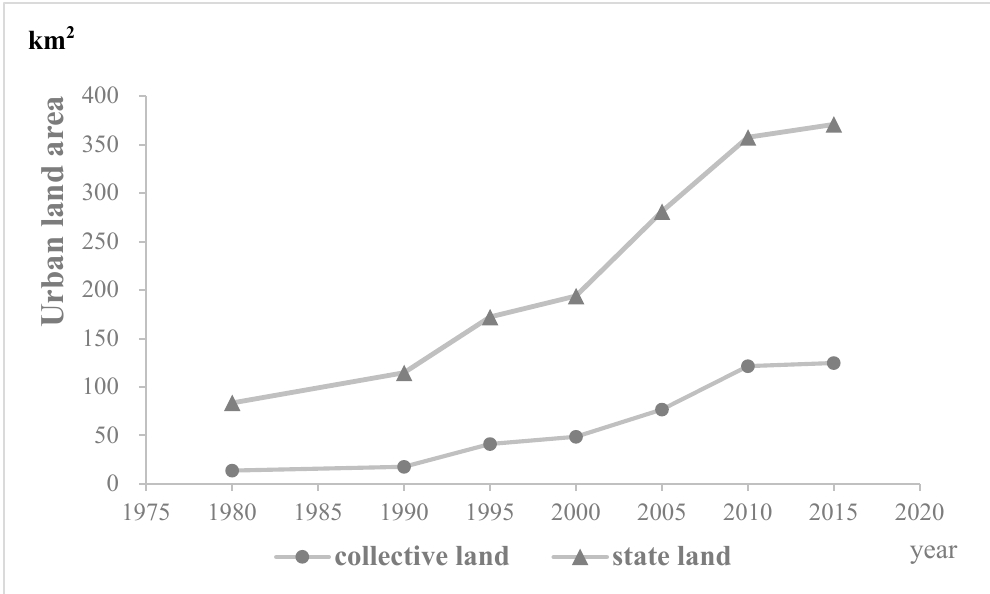
Figure 5. Spatial allocation of state land and collective land in 1980, 1990, 1995, 2000, 2005, 2010, and 2015. (Source: drawn by the authors).